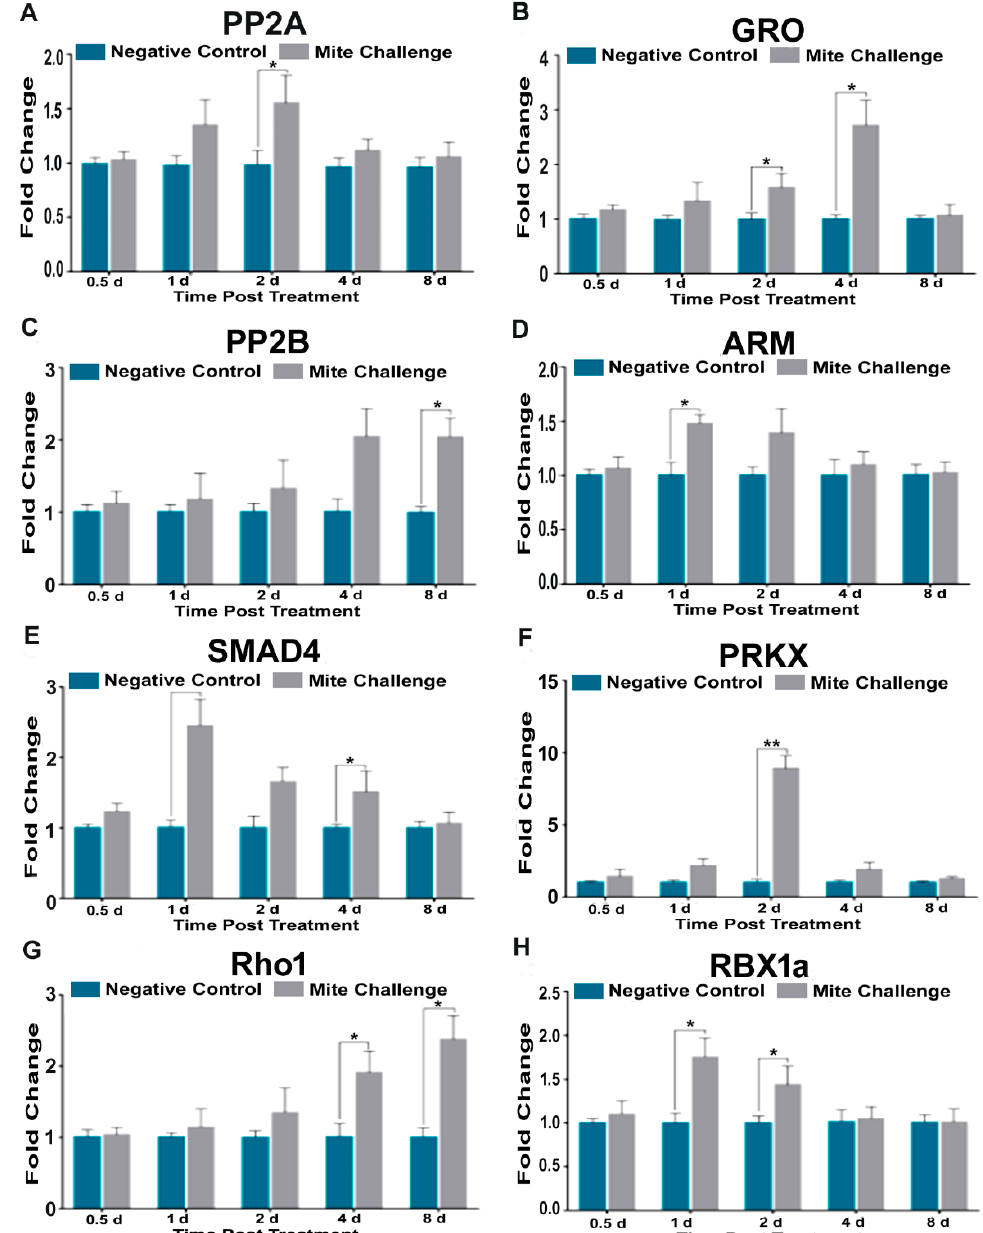
Figure 7. Fold chance of the transcription profiles for multiple elements of Wnt signaling between the negative control (without Varroa challenge) and bees challenged with Varroa mites at different time points post treatment (days). ( A ) phosphatase 2A (PP2A), ( B ) transcriptional repressor groucho (GRO), ( C ) phosphatase 2B (PP2B), ( D ) segment polarity gene armadillo (ARM), ( E ) transcription factor SMAD4, ( F ) kinase PRKX, ( G ) GTP binding protein Rho1, and ( H ) E3-ubiquitin ligase RBX1a demonstrating similar expression patterns to Toll pathway components of immunity (* p < 0.05, ** p < 0.01).